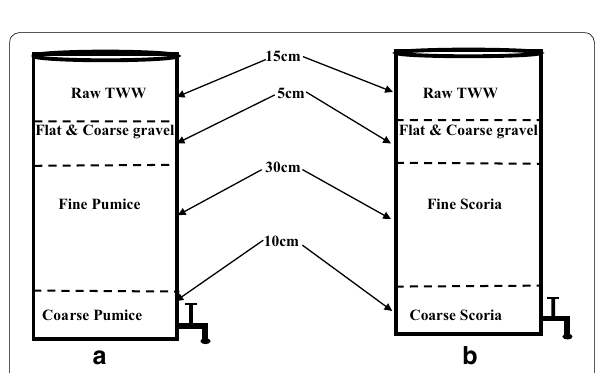
Fig. 4 Schematic layout of the filter tanks a components of pumice, b components of